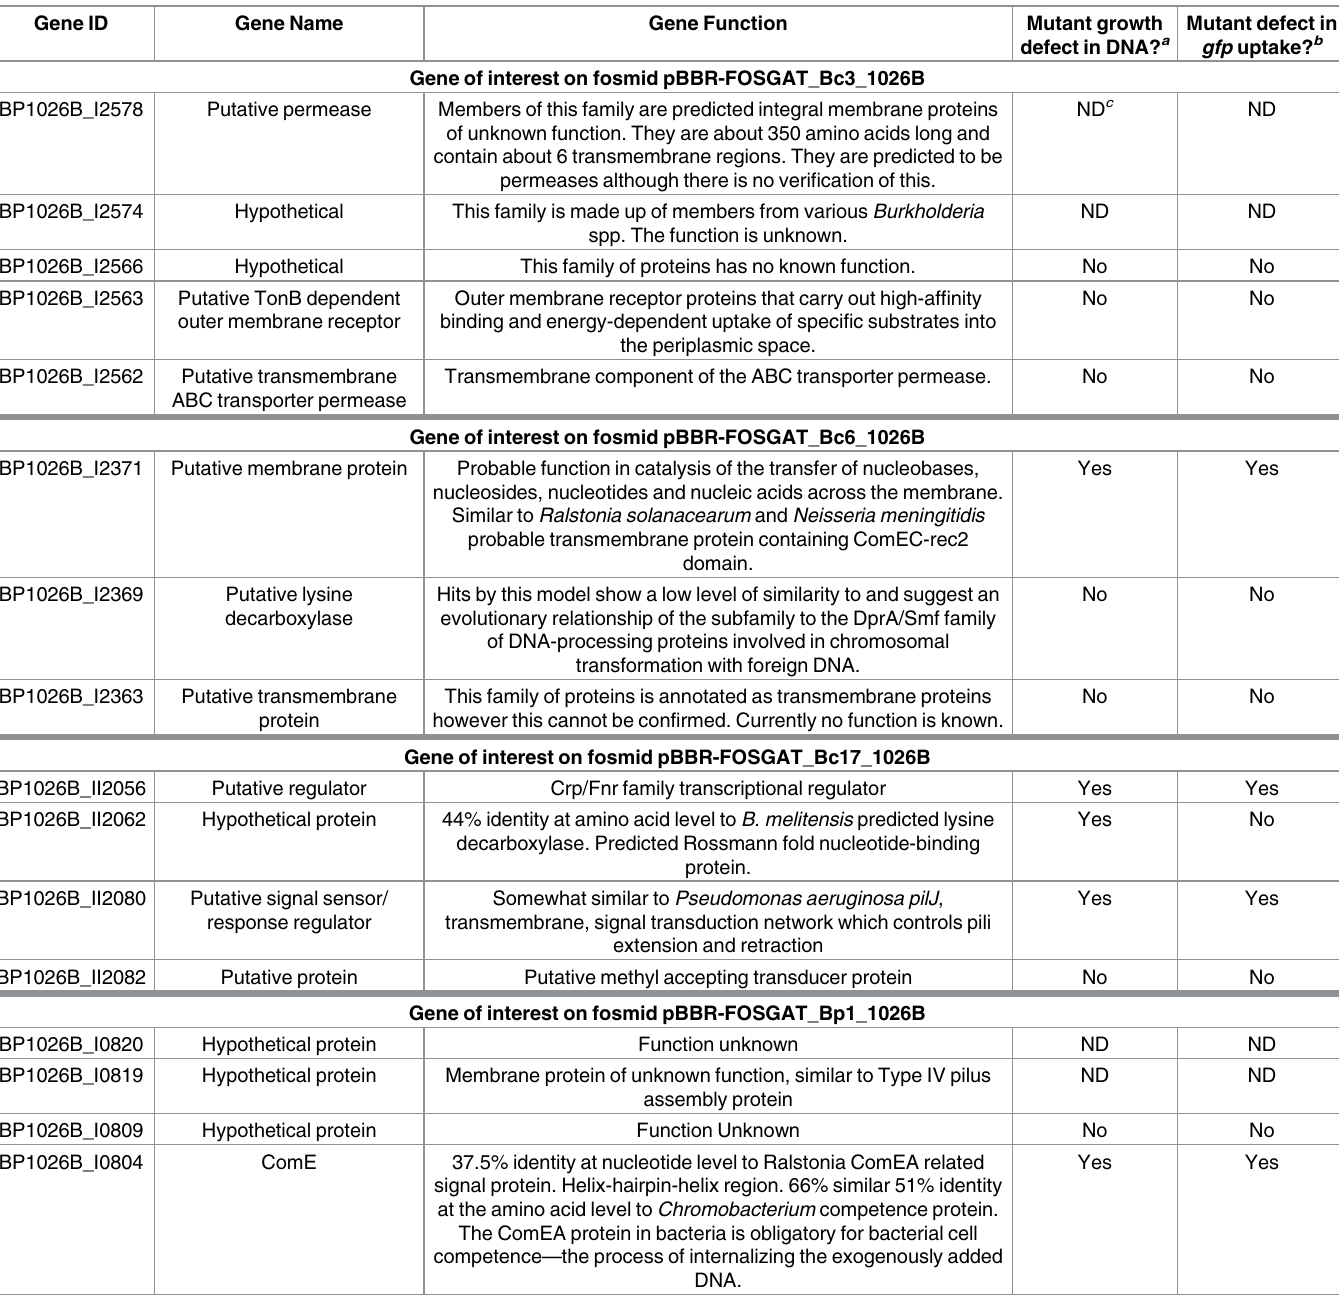
Table 1. Characterization of selected genes from fosmids. Gene